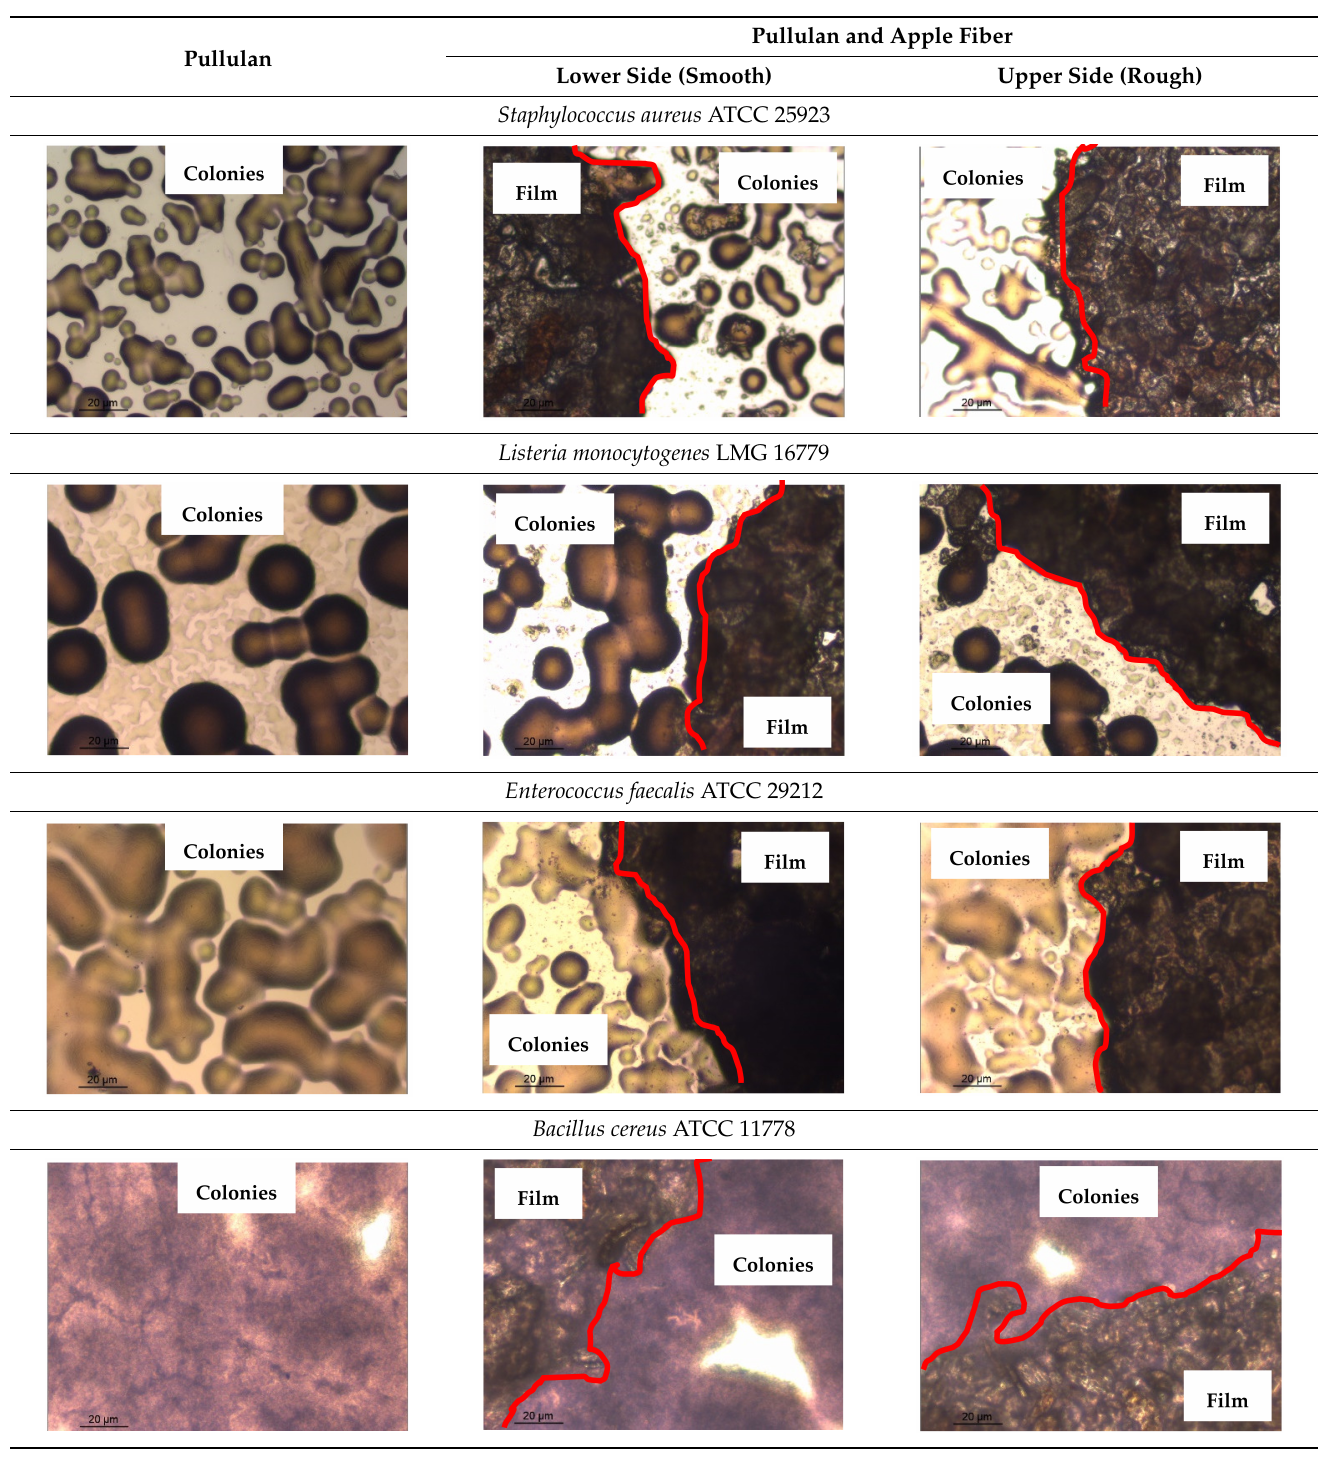
Table 6. Optical microscopy images of antibacterial activity (Magnification: 400 ×